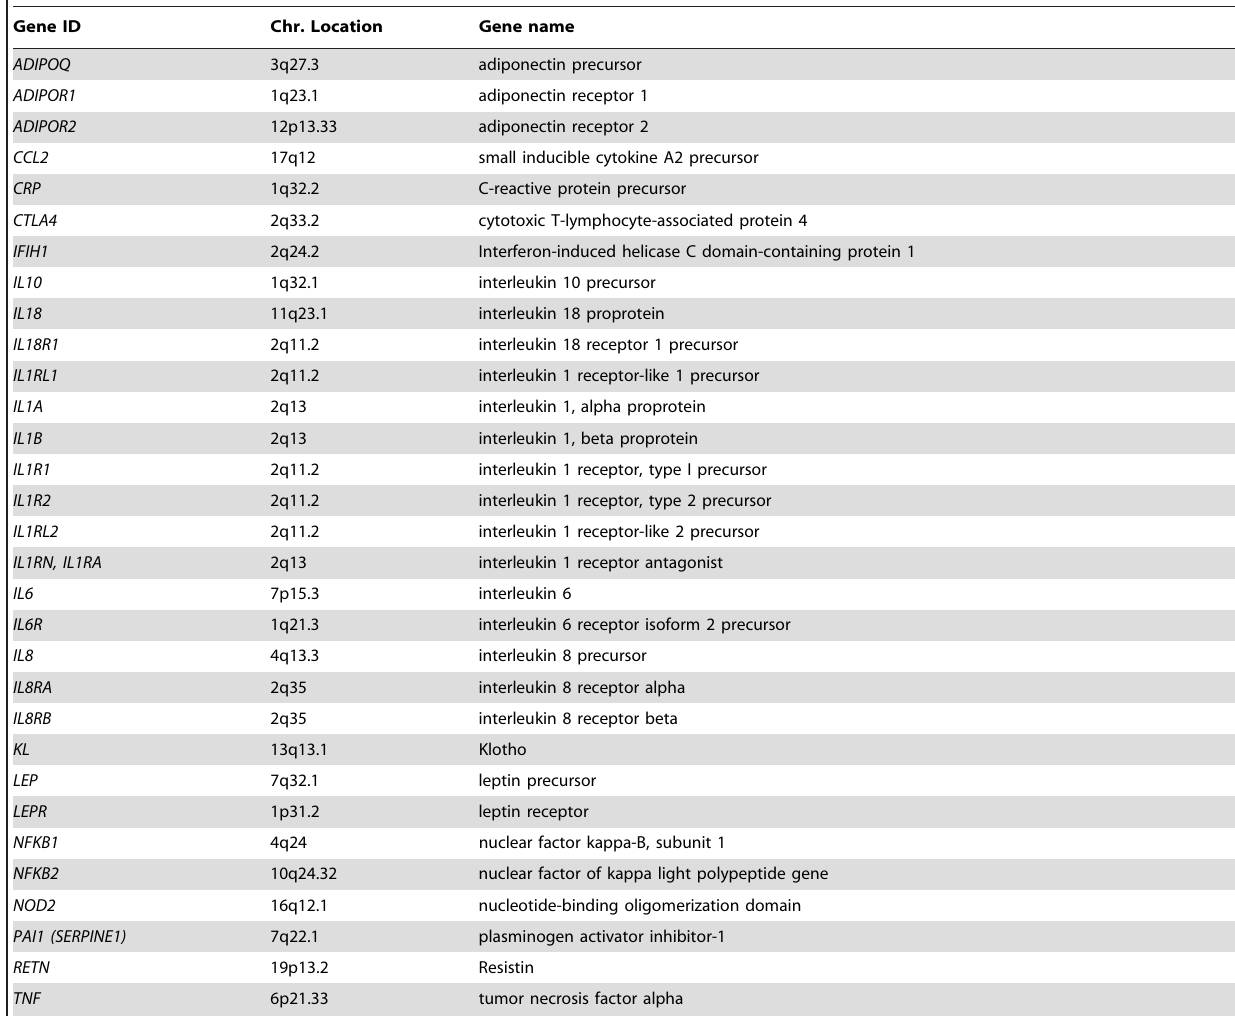
Table 1. List of